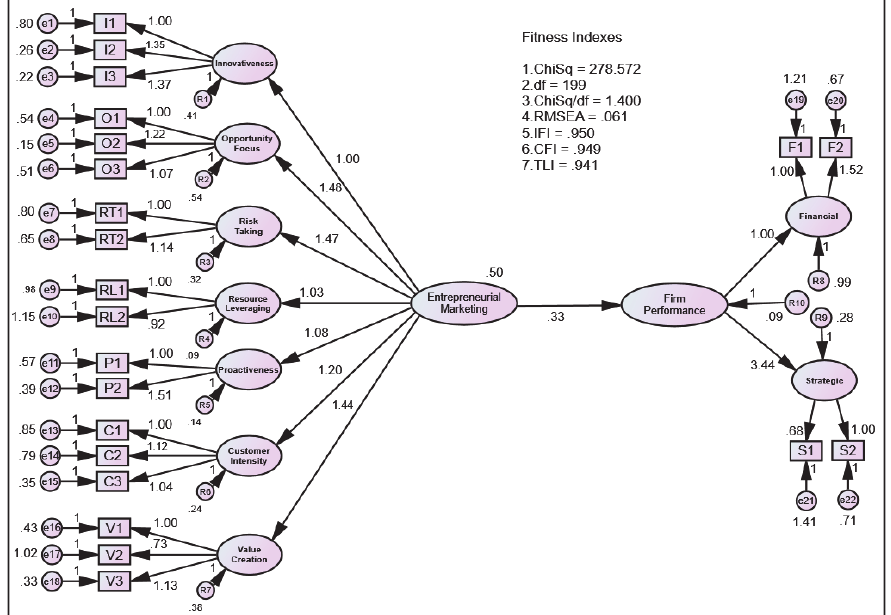
Fig. 8. Female Group: Unconstrained Model Output Chi-Square Value and DF for Unconstrained Model (Female Group) Model NPAR CMIN DF P CMIN/DF Default model 54 278.572 199 .000 1.400 Saturated model 253 .000 0 Independence model 22 1788.950 231 .000 7.744